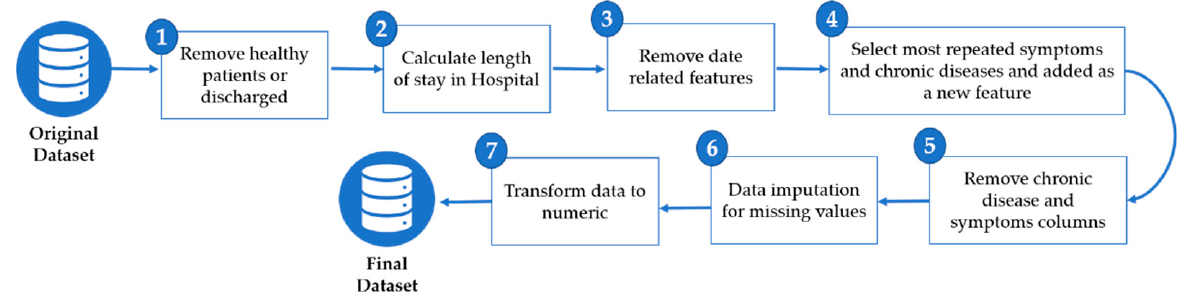
Figure 2. Data preprocessing steps.